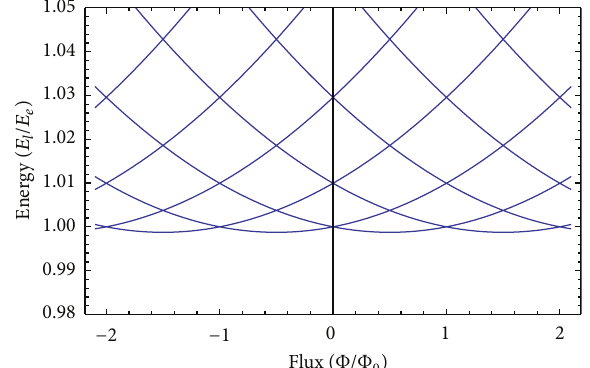
Figure 2: Energy as a function of flux. Here we have used ℎ = 𝑐 = = 1 ( 𝑒 and 𝑚 𝑒 = 𝑚 𝑒 𝑒 being electronic charge and mass. The units of mass, length, and energy are 𝑚 𝑒 , 𝑟 𝑒 = ℎ/𝑚 𝑒 𝑐 , and 𝐸 𝑒 = 𝑚 𝑒 𝑐 2 ). The ring radius and particle mass are 𝑅 = 10𝑟 𝑒 and 𝑚 = 1𝑚 𝑒 , respectively. The energy minima are at Φ/Φ 0 = 𝑙 + 1/2 . This shift is a signature of relativistic